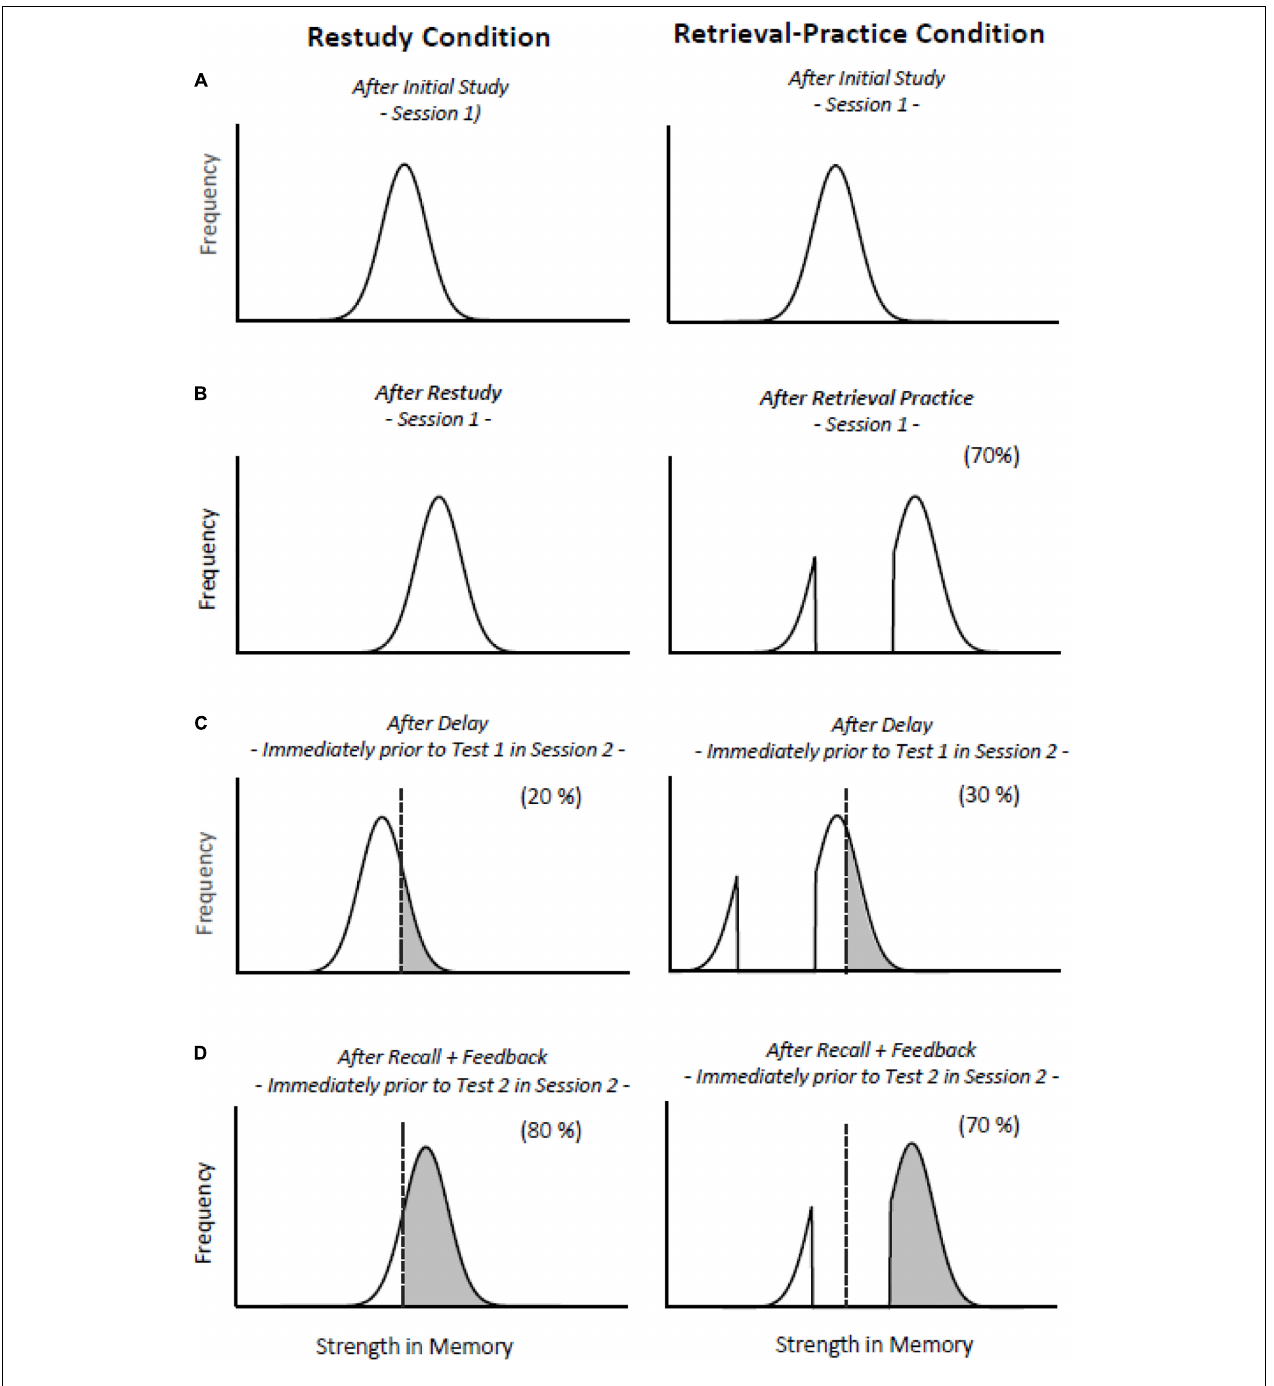
FIGURE 1 | An illustration of the distribution-based bifurcation model (Halamish and Bjork, 2011; Kornell et al., 2011). The left and right columns show the hypothetical strength distributions of items after restudy practice and items after retrieval practice. (A) After initial study of a list of items in Session 1, the strength distributions are assumed to be identical and normal in the restudy and retrieval-practice conditions. (B) All restudied items gain memory strength about equally, whereas the distribution of the retrieval-practiced items becomes bifurcated: Successfully retrieved items get a boost in strength, whereas items not successfully retrieved do not gain any strength. Critically, the boost for successfully retrieved items is more pronounced than for restudied items. (C) All items are assumed to lose strength with delay, but, due to the bifurcated item distribution, the decline in recall may be less dramatic following retrieval practice than restudy. More of the retrieval-practiced than restudied items are above recall threshold after delay. The recall threshold is represented by the dotted, vertical line. (D) In both practice conditions, items that are successfully recalled in Test 1 are strengthened. Items that are not successfully recalled in Test 1 are strengthened by subsequent feedback, so that all items gain strength after recall and